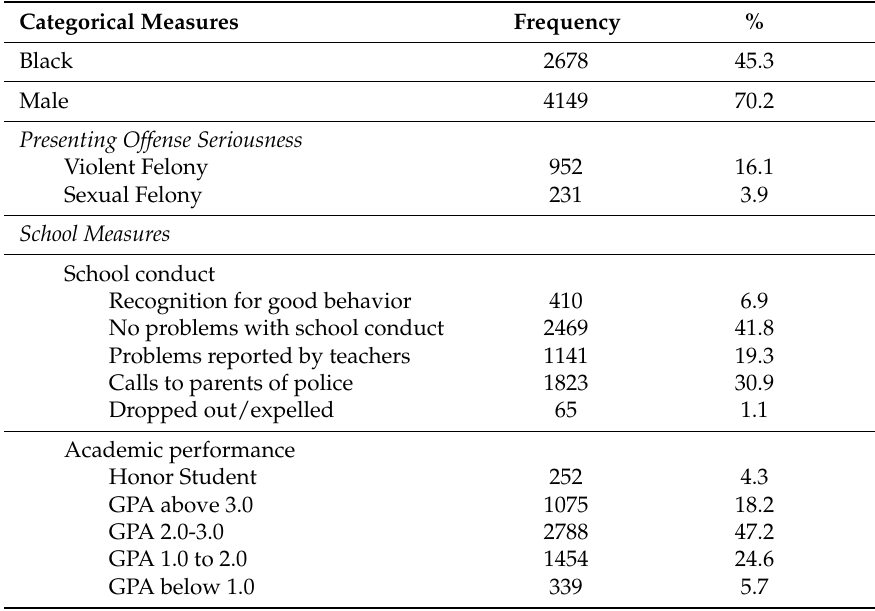
Table 1. Descriptive statistics for the analysis of prospective homicide offenders ( n =